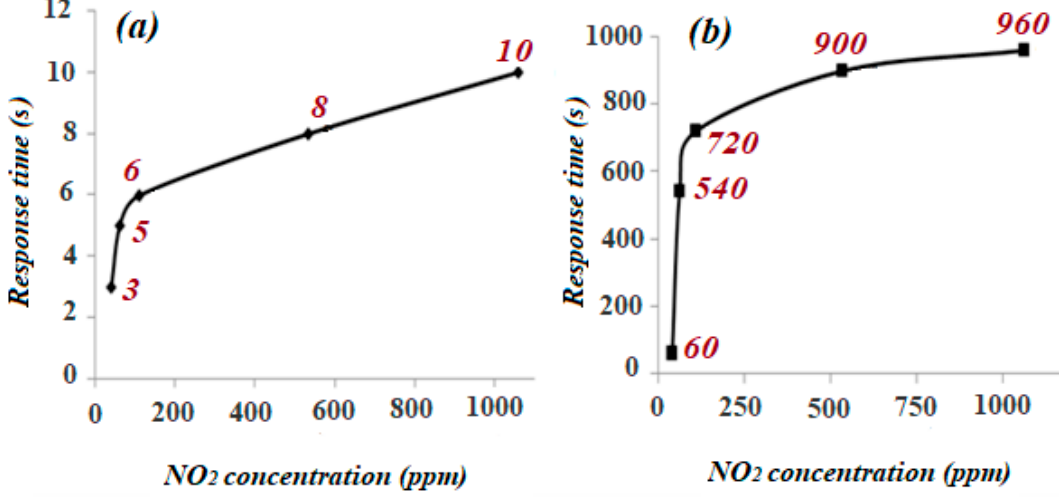
Figure 5. Dependences of sensor response on NO 2 concentration (for the samples thermally treated at 200 °C (1) and 500 °C (2); operating temperature of 25 °C).